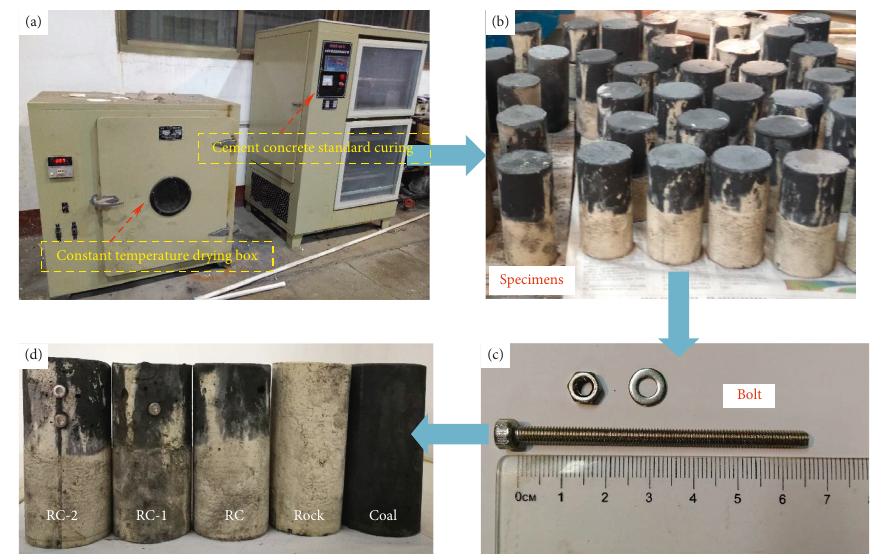
Figure 3: Specimen curing formation: (a) maintenance equipment; (b) specimens; (c) bolt; and (d) molding